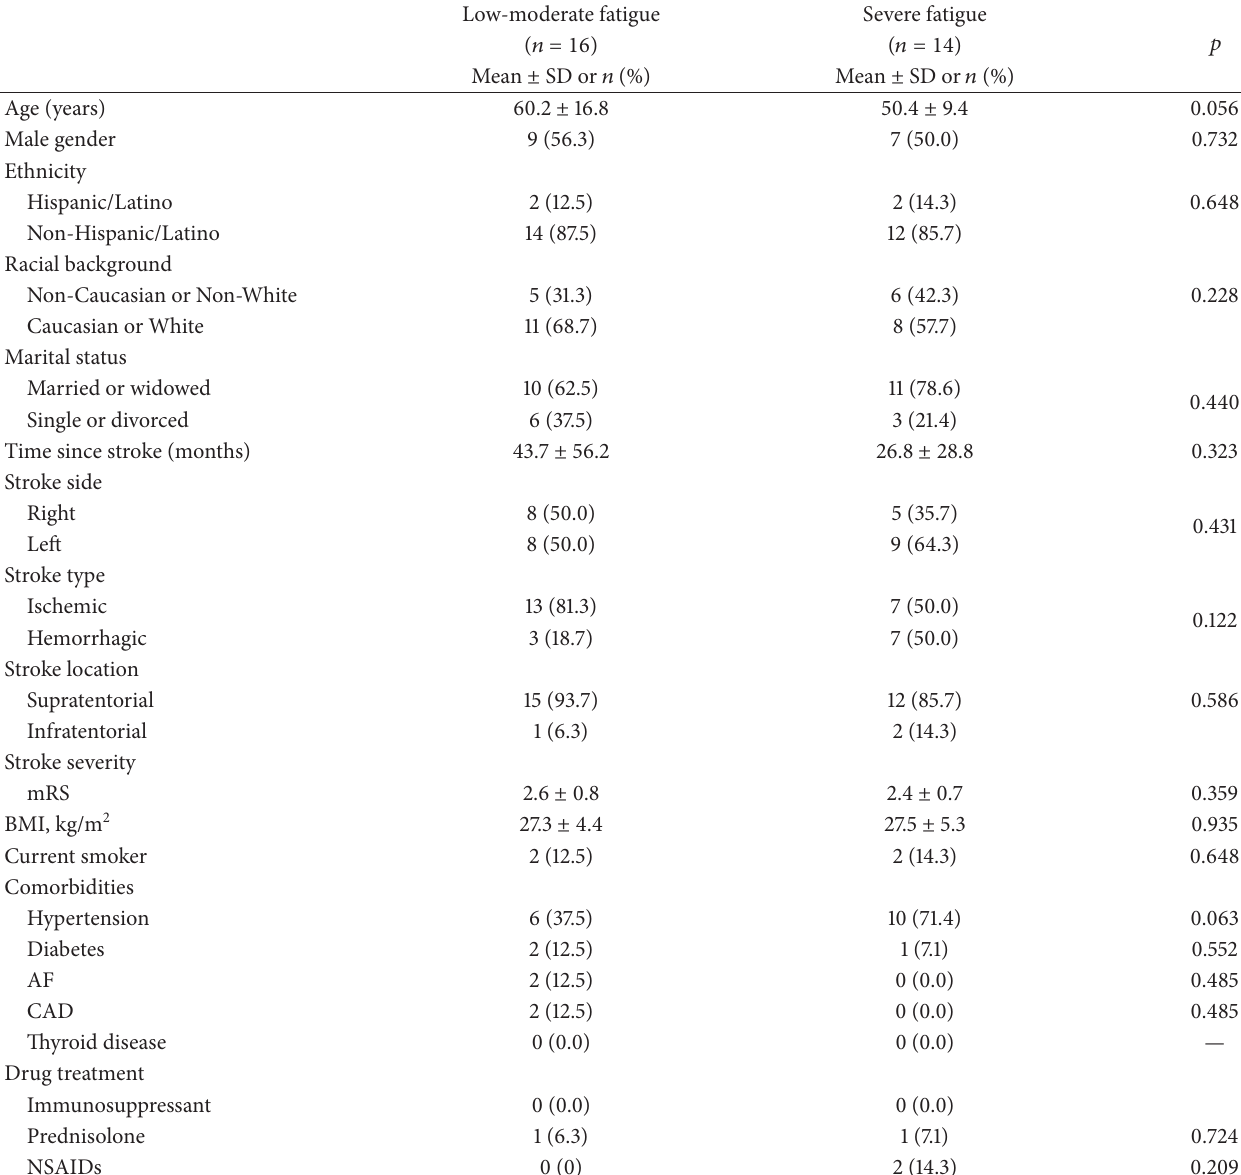
Table 1: Participant demographic and clinical